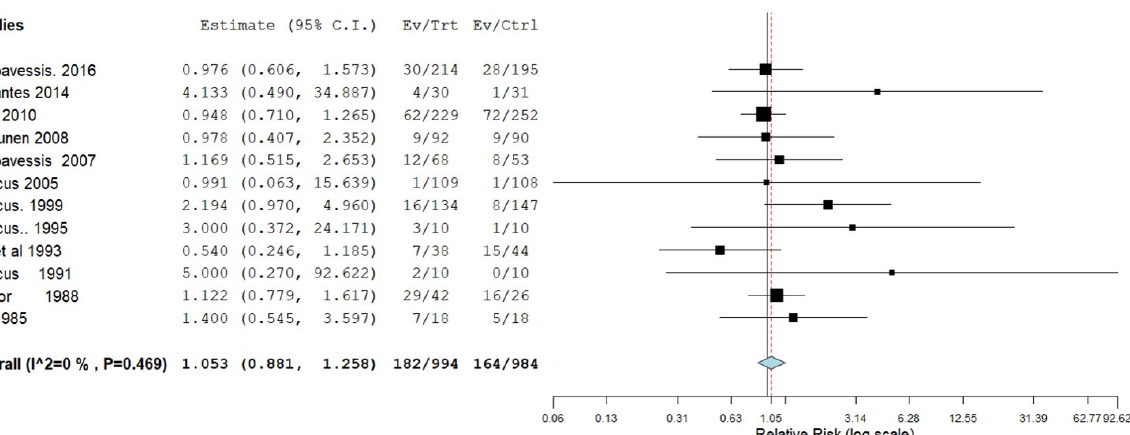
Figure 3. Forest plot for the success of Smoking cessation (SC). CI: confidence interval; Ev: number of quitters in the exercise group/s at the last follow-up session; Trt: number of participants in the exercise group at baseline; Ctrl: number of participants in the non-exercise group/s at baseline session. References cited in the figure are: [37–48].